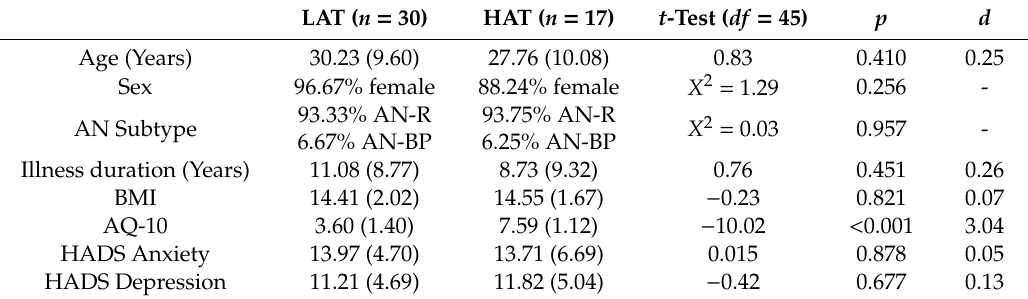
Table 1. Summary of group di ff erences on clinical and demographic characteristics.